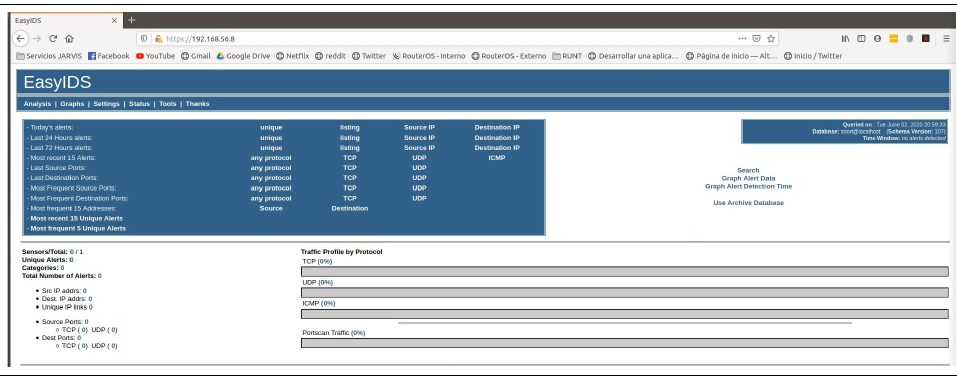
Figure 7. Snort Injection Attack result.